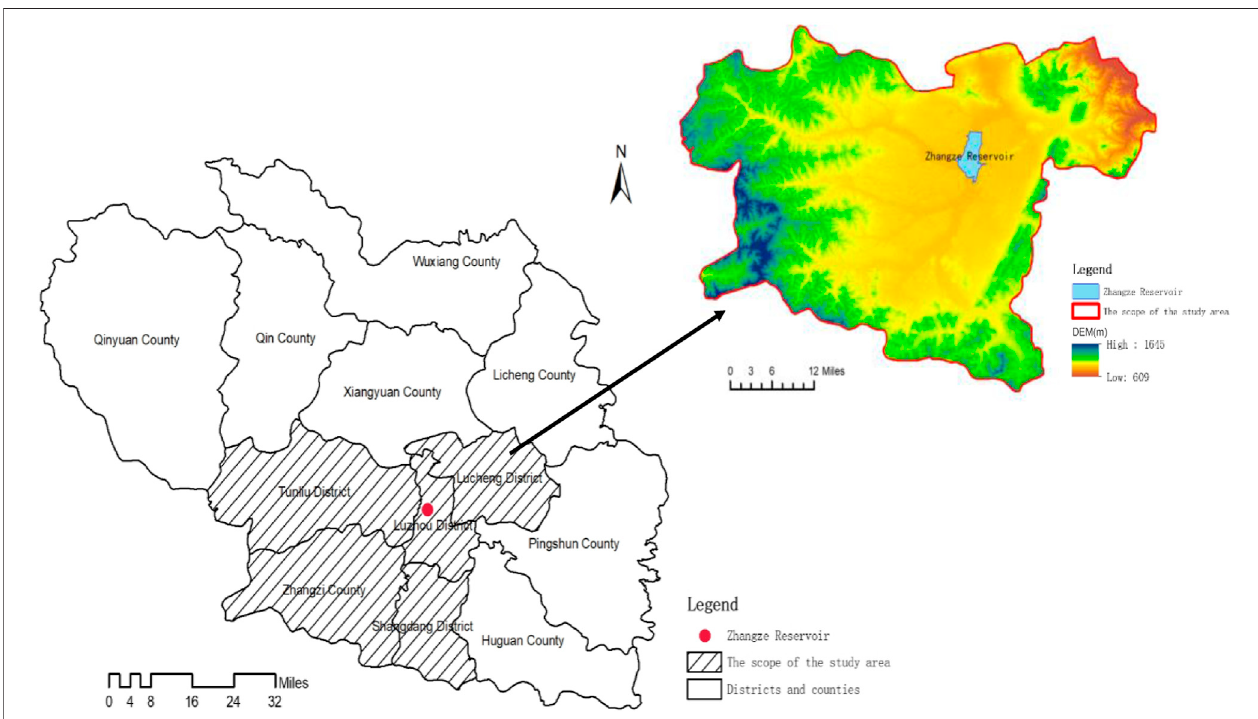
FIGURE 1 | Location map of the study